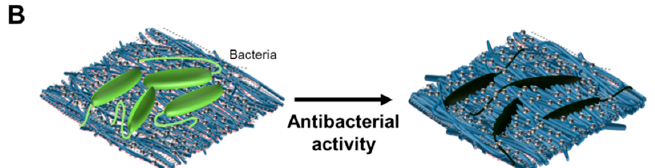
Figure 1. Schematic figures of ( A ) the anisotropic carboxylated cellulose nanofibers (CCNF)-dopamine (DA)/silver nanoparticles (AgNPs) composite formation process; and ( B ) the antibacterial activity of CCNF-DA/AgNPs composite.